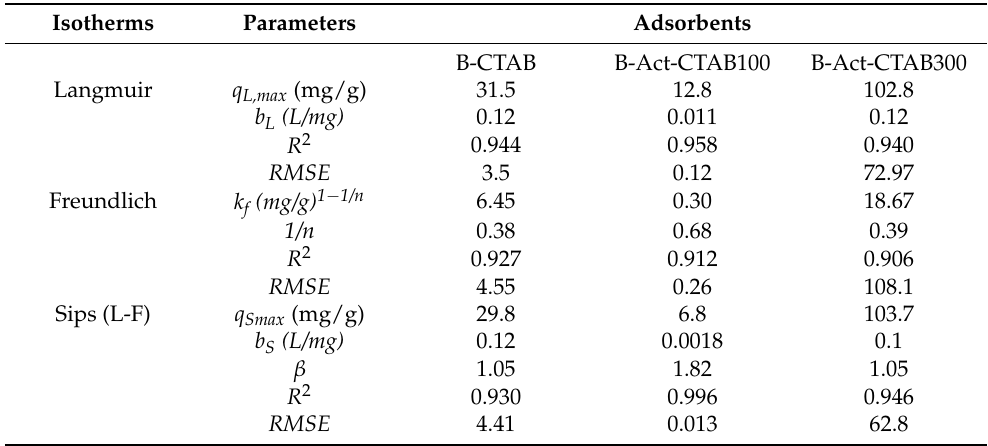
Table 5. Langmuir, Freundlich and Sips isotherm model parameters for OG dye adsorption onto B-CTAB, B-Act-CTAB100 and B-Act-CTAB300.